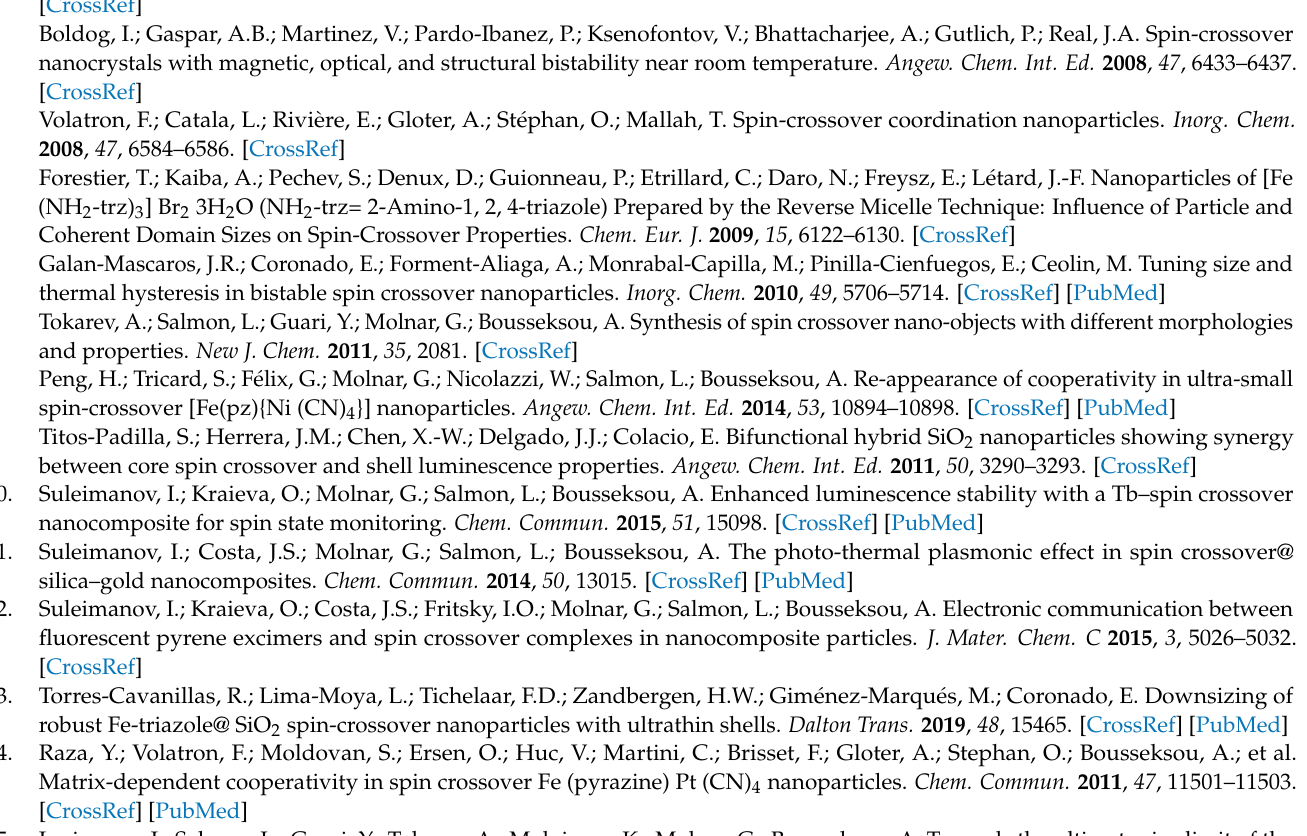
ses. Figure S2: Transmission Electronic Microscopy (TEM) and EDX analyses. Figure S3: Infrared spectroscopy. Figure S4: Optical reflectivity measurements for samples